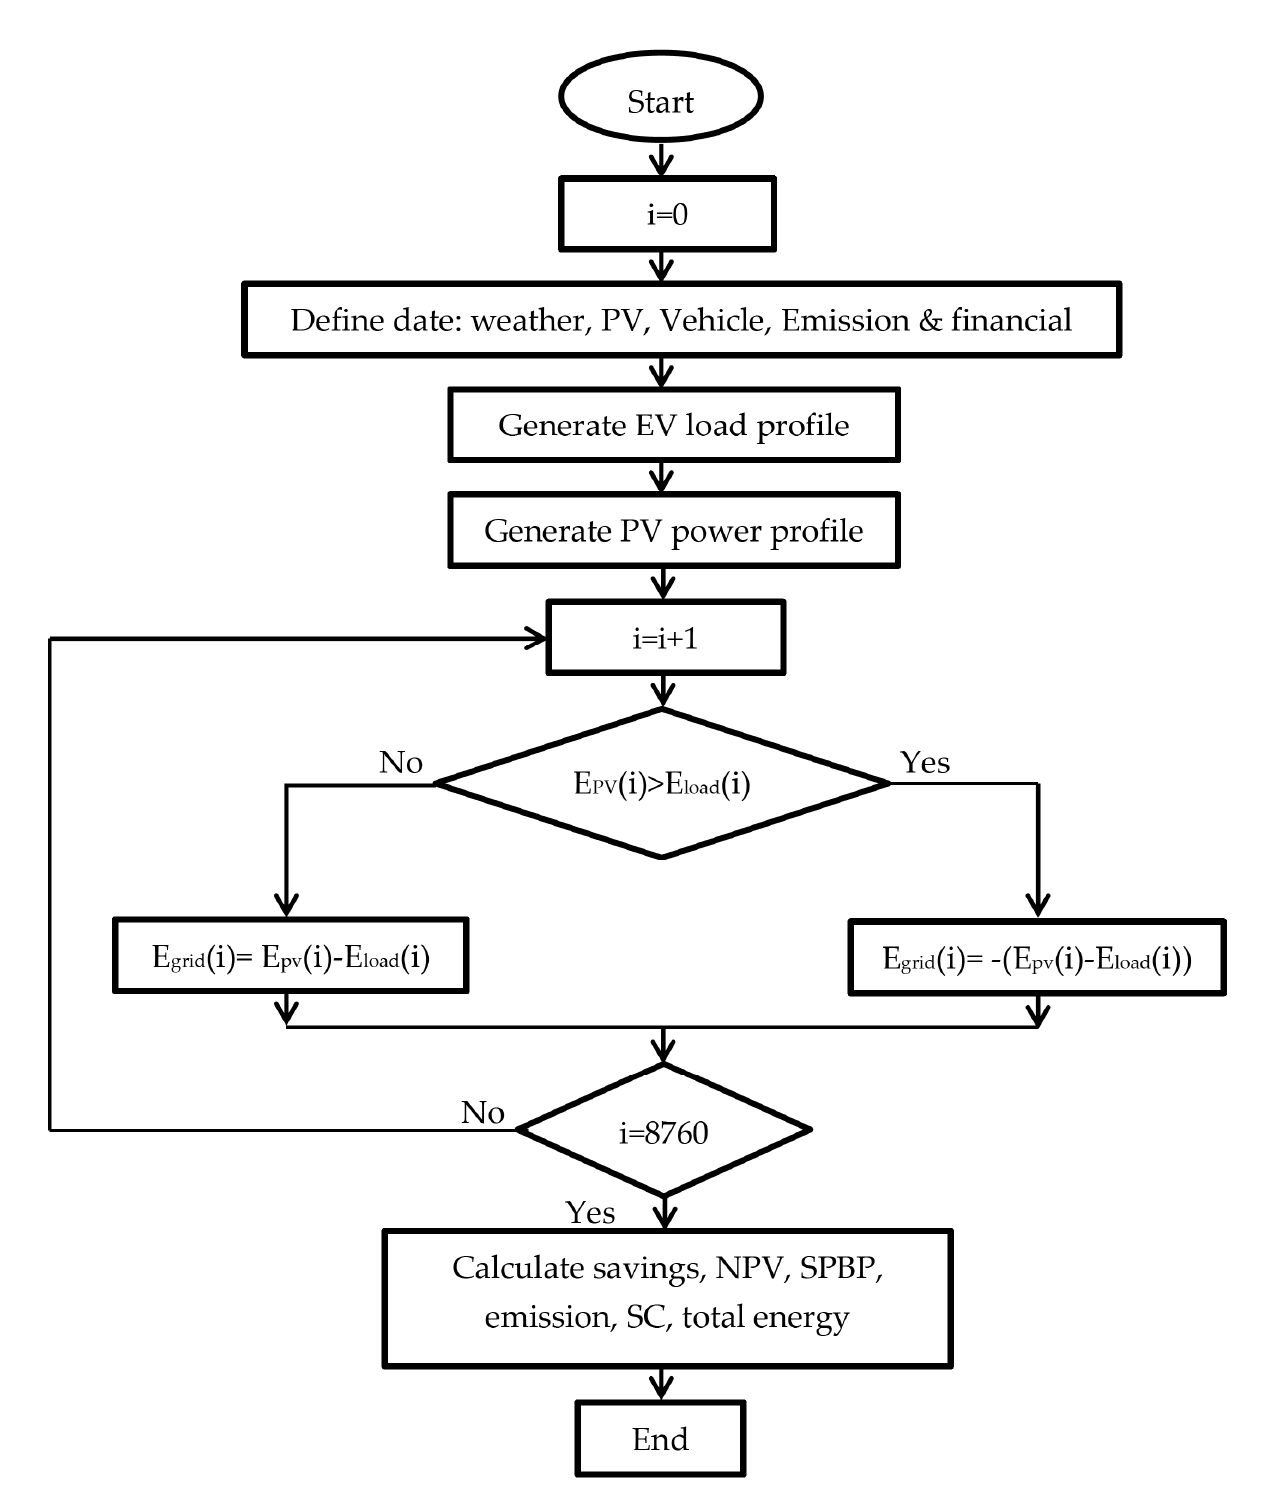
Figure 3. Flow chart of energy flow model of EV–PV − grid .